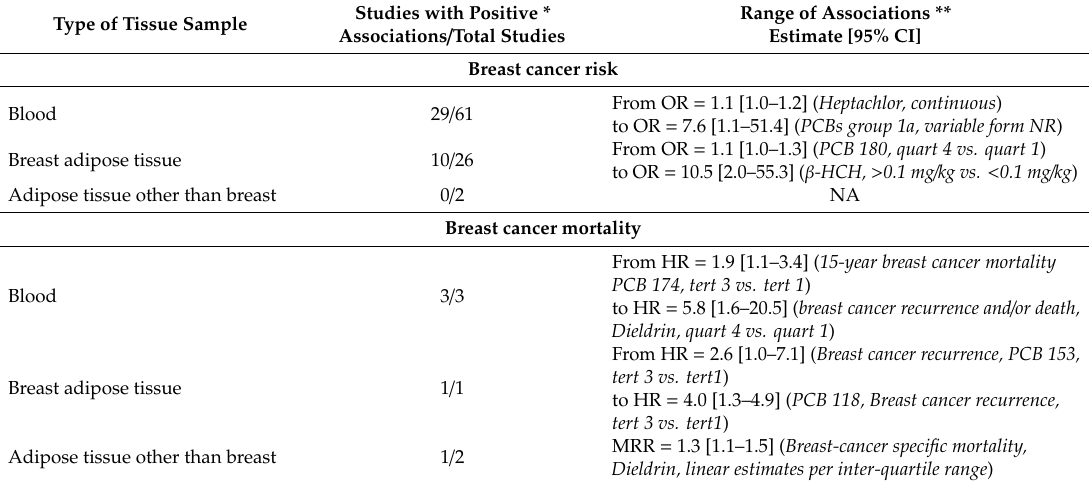
Table 4. Main results summary of studies reporting positive * associations between POPs and breast cancer risk and